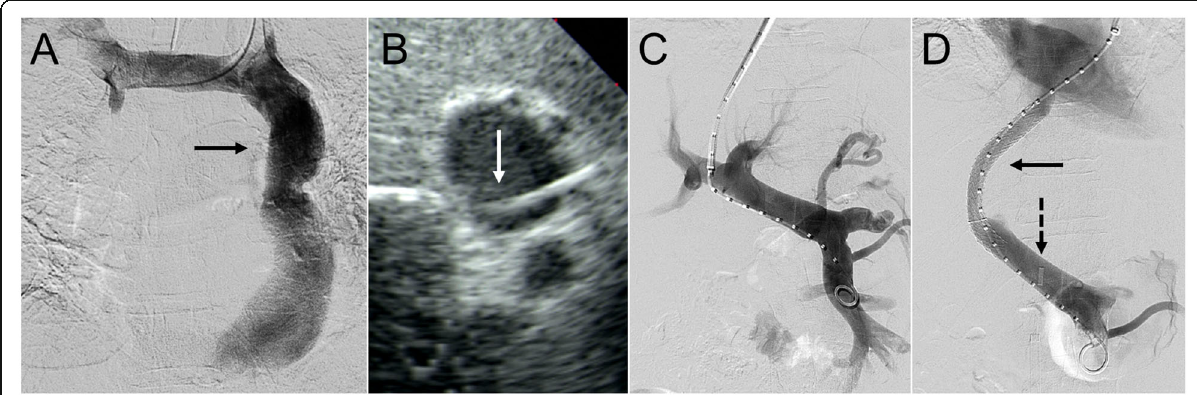
Fig. 2 A middle-aged man with end-stage liver disease, hepatitis C, recurrent ascites, and isolated persistent left superior vena cava. a Left internal jugular venography demonstrating the isolated persistent left superior vena cava (solid arrow). b Perpendicular-projecting intravascular ultrasound-guided access to the right portal vein (solid arrow). c Portal venography was performed. d A 10-mm × 6-cm (covered) / 2-cm (uncovered) Viatorr stent-graft was deployed (solid arrow) resulting in widely patent TIPS. A perpendicular-projecting intravascular